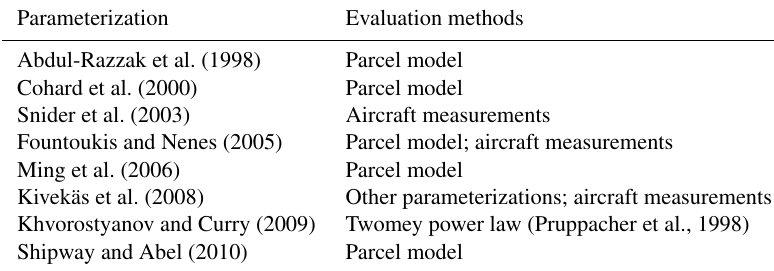
Table 1. A summary of activation parameterizations and the evaluation methods in previous studies. Parameterization Evaluation methods Abdul-Razzak et al. (1998) Parcel model Aircraft measurements Parcel model; aircraft measurements Ming et al. (2006) Parcel model Kivekäs et al. (2008) Other parameterizations; aircraft measurements Khvorostyanov and Curry (2009) Twomey power law (Pruppacher et al., 1998) Shipway and Abel (2010) Parcel